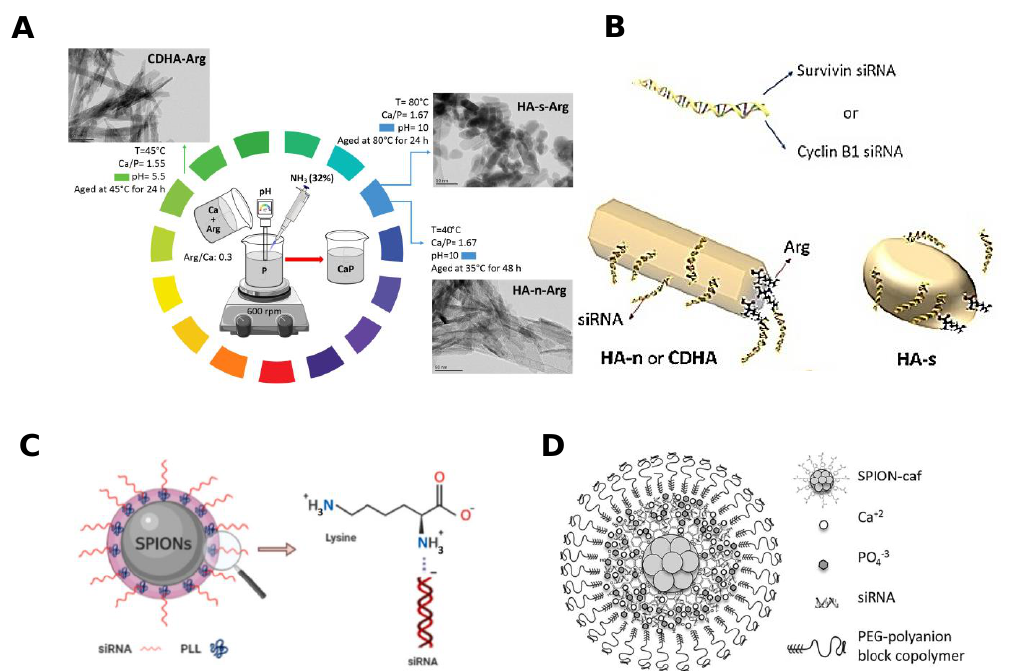
Figure 5. ( A ) Schematic diagram of CaP nanoparticles with different chemical and morphological characteristics and a simplified diagram for the delivery of survivin and cyclin B1-specific siRNA. ( B ) Through this procedure, acicular hydroxyapatite (HA-N), spherical hydroxyapatite (HA-S) and calcium-deficient hydroxyapatite (CDHA) with average particle sizes of 15, 38, and 20 nm were obtained. The aspect ratio of HA-N and CDHA is about 6. CaP-Arg-siRNAs effectively down- regulated the expression of survivin and cyclin B1 genes to significantly induce cell apoptosis [25]. Copyright 2020, Elsevier. ( C ) Schematic diagram of gene carrier system of superparamagnetic iron oxide nanoparticles (SPIONs). The consists of SPION coated with the biocompatible protein sericin (Ser) and modified with the cationic polymer polylysine (PLL) to bind negatively charged siRNA [102]. Copyright 2021, Elsevier. ( D ) Structure diagram of caffeic acid-magnetic calcium phosphate (CAFA- MCAP) nanoparticles. The nucleus consists of superparamagnetic iron oxide nanoparticles (SPION) coated with caffeic acid and stabilized by calcium phosphate, siRNA, and PEG-polyanionic block copolymer layers [103]. Copyright 2020,